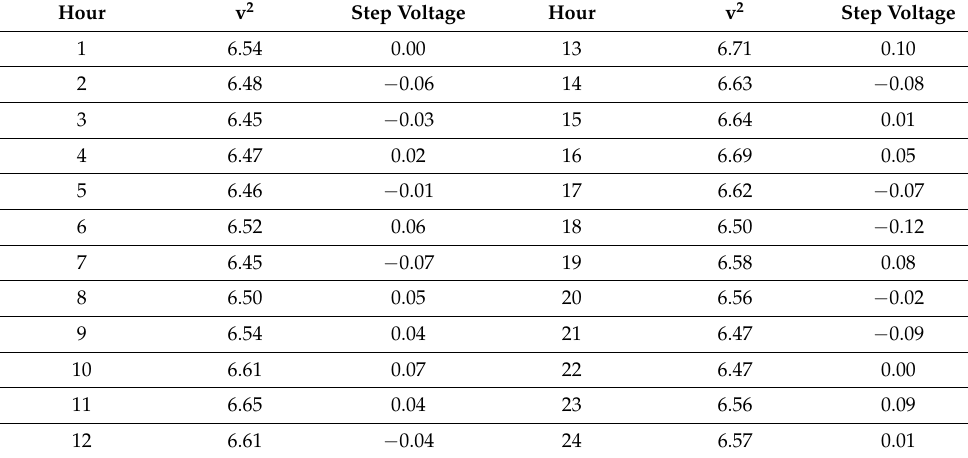
Table 12. Hourly step voltage or voltage ramp in kV for Table 11. Hourly step voltage or voltage ramp in kV for FA.